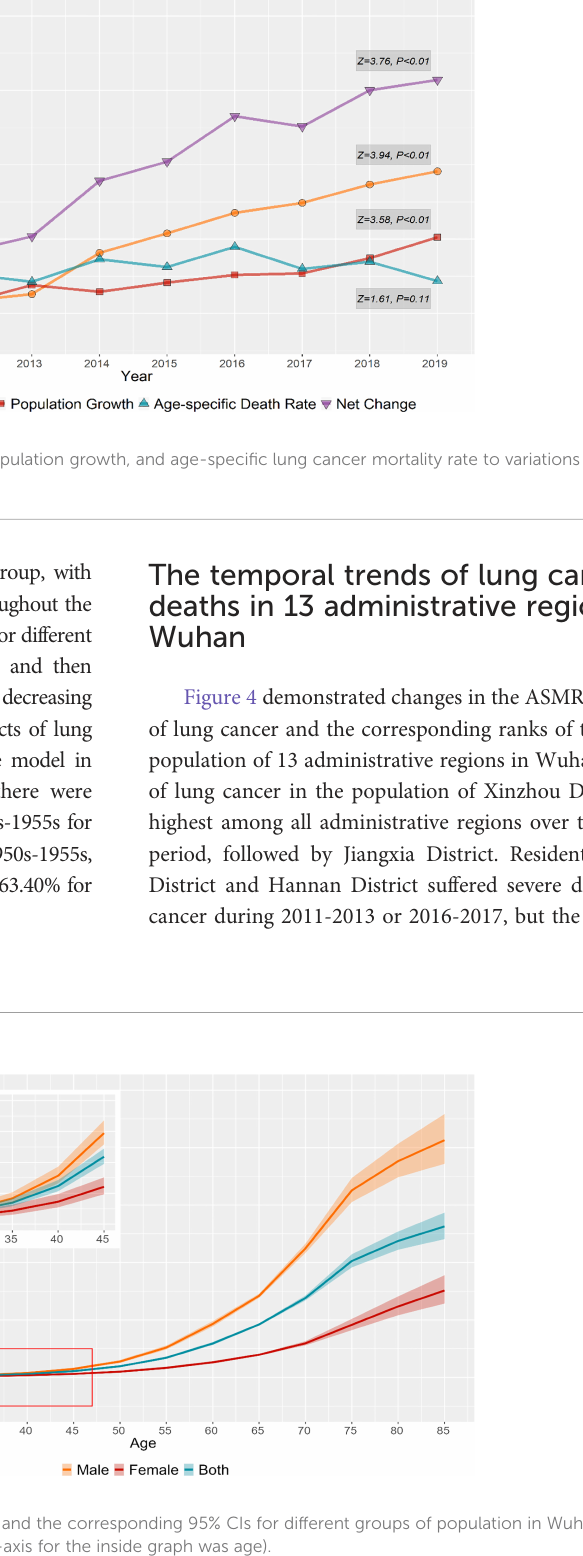
FIGURE 2 The longitudinal age curves of lung cancer mortality rate and the corresponding 95% CIs for different groups of population in Wuhan (the y-axis for the inside graph was lung cancer mortality, and the x-axis for the inside graph was age).